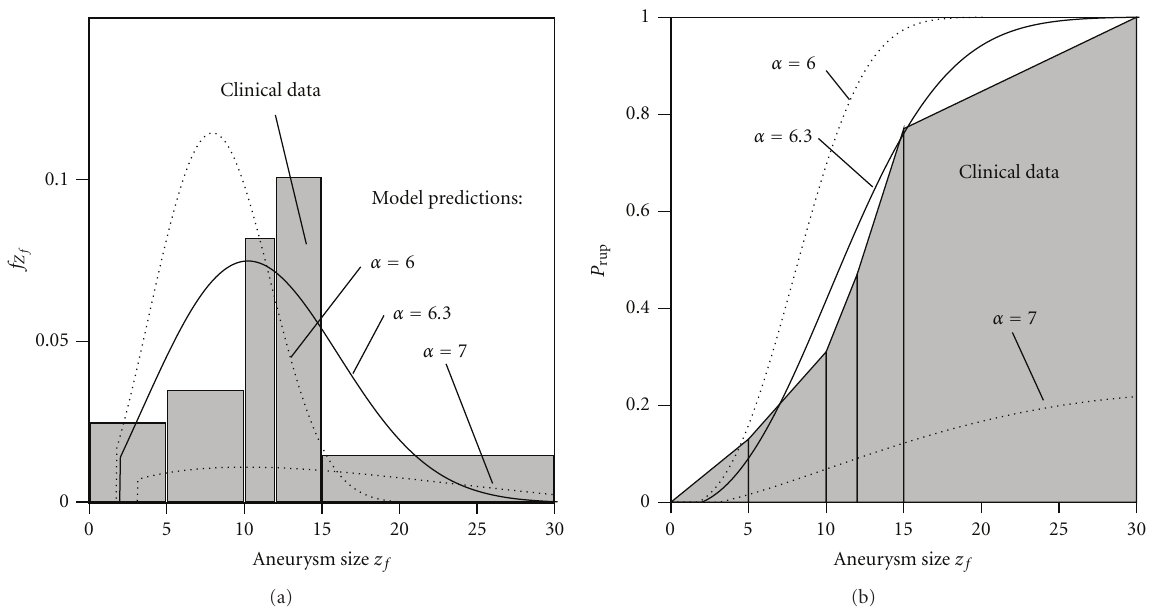
Figure 7: Comparison between clinical data from [1] and predicted risk of aneurysm rupture. Total number of ruptured aneurysms in clinical study: 79. Shaded bars and areas indicate clinical results, and lines indicate model predictions. (a) Density function for risk of rupture versus aneurysm size. (b) Rupture risk (distribution function) versus aneurysm